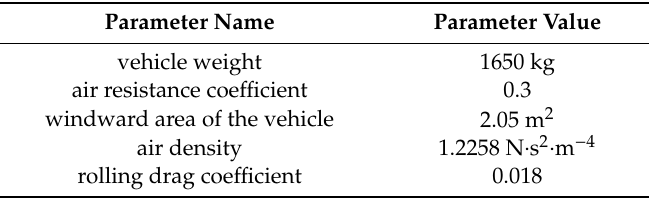
Table 4. Simulation parameters.